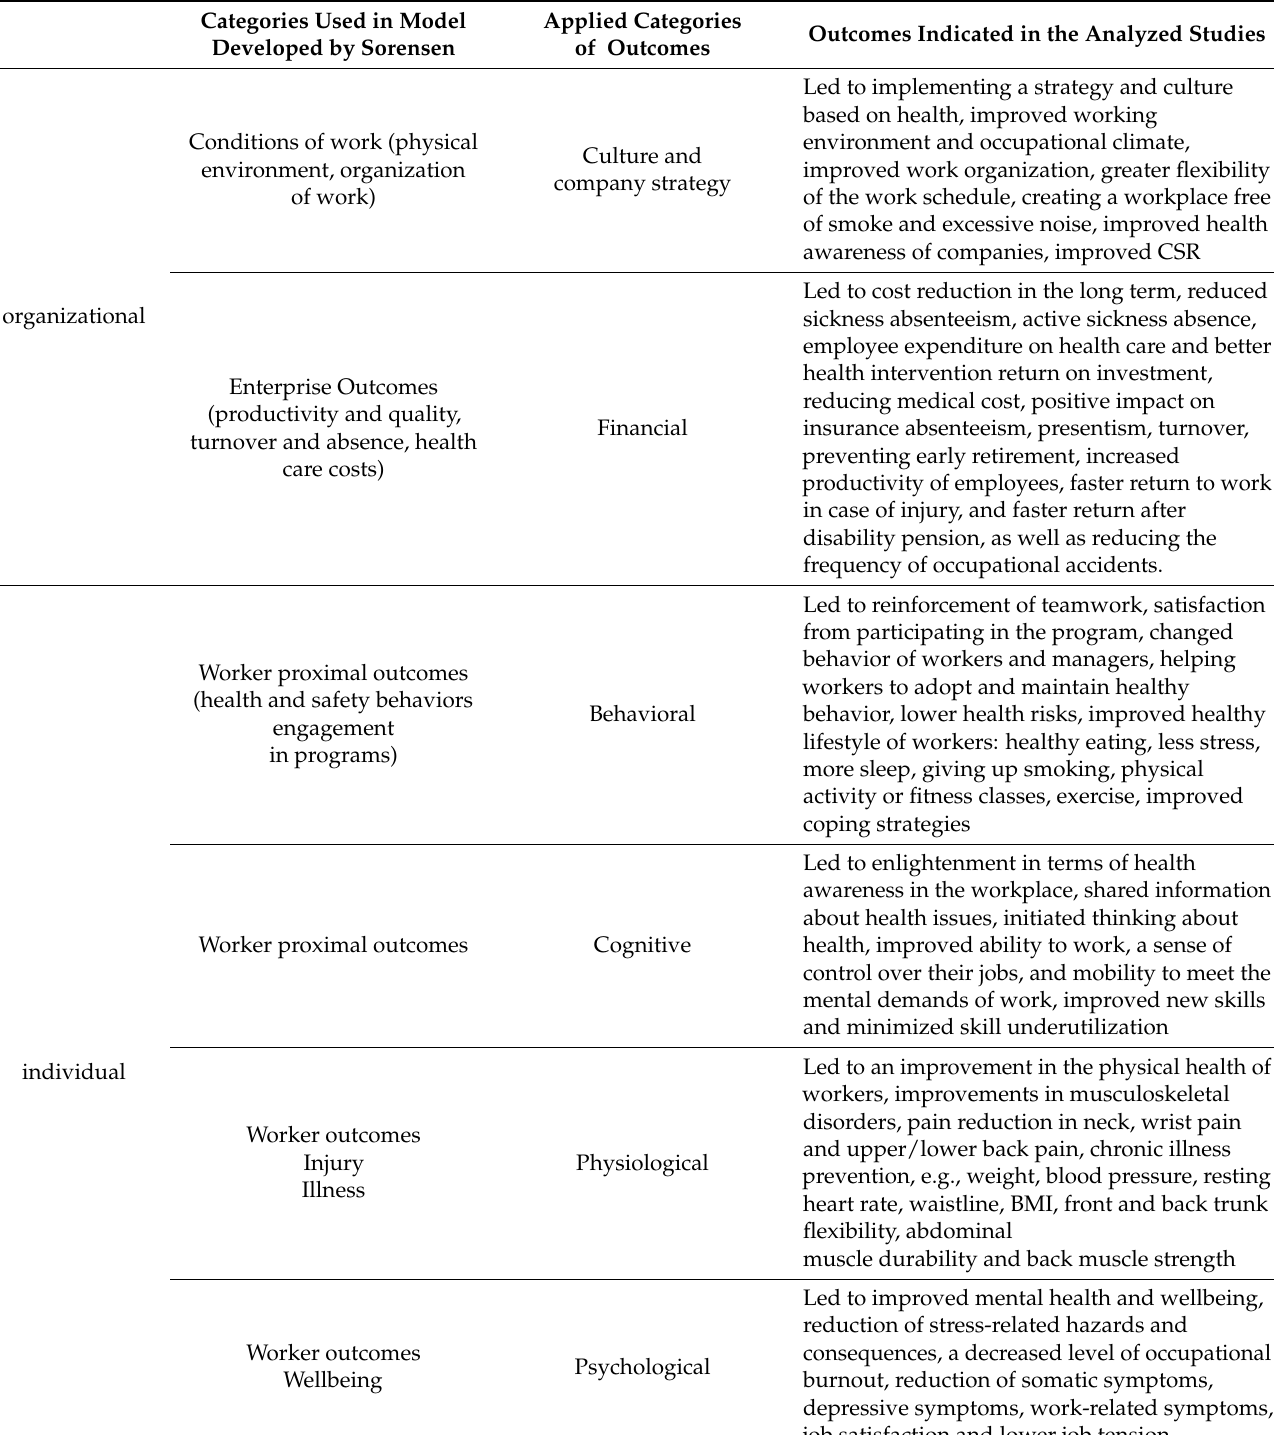
Table 2. Categories of organizational and individual outcomes with characteristics based on the systematic review. Categories Used in